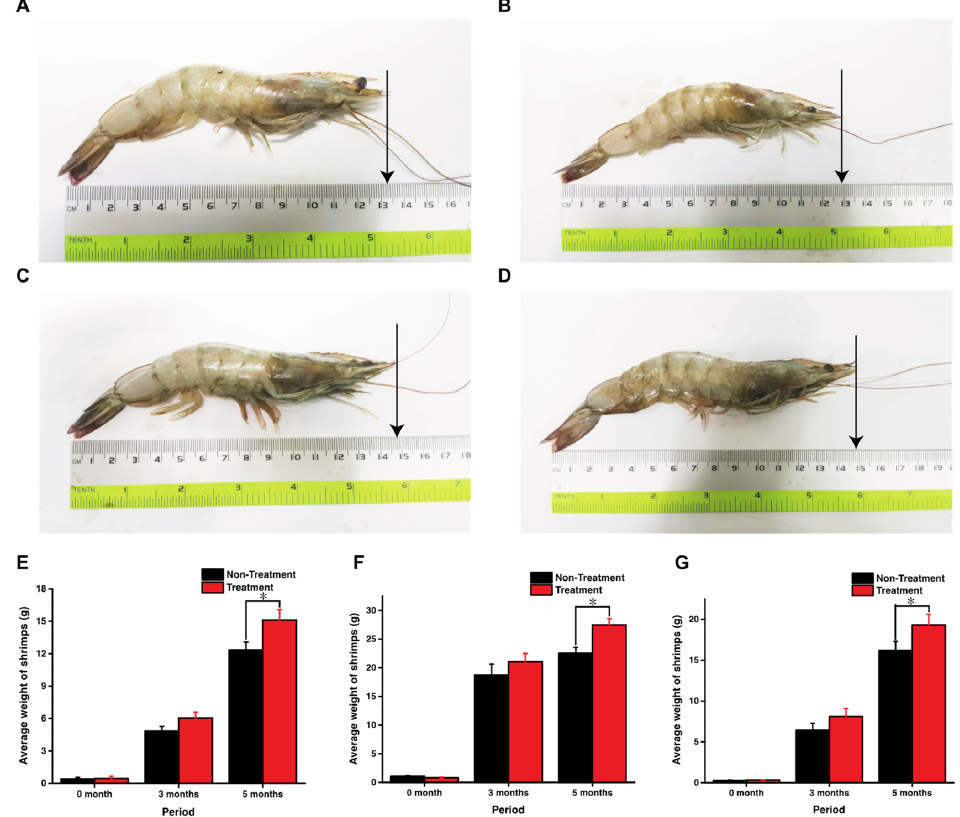
Figure 4. The growth of L. vannamei after treatment with kefir. ( A , B ) Representative images of the length of L. vannamei in the non-treated group. ( C , D ) Representative images of the length of L. vannamei in the kefir-treated group. Black arrows indicate the end of head of L. vannamei . ( E ) The average weight of L. vannamei after treatment with kefir in shrimp farm #01. ( F ) The average weight of L. vannamei after treatment with kefir in shrimp farm #02. ( G ) The average weight of L. vannamei after treatment with kefir in shrimp farm #03. The average weight of L. vannamei was calculated by the average weight of 100 L. vannamei individuals. * p < 0.05, accessed using the paired t